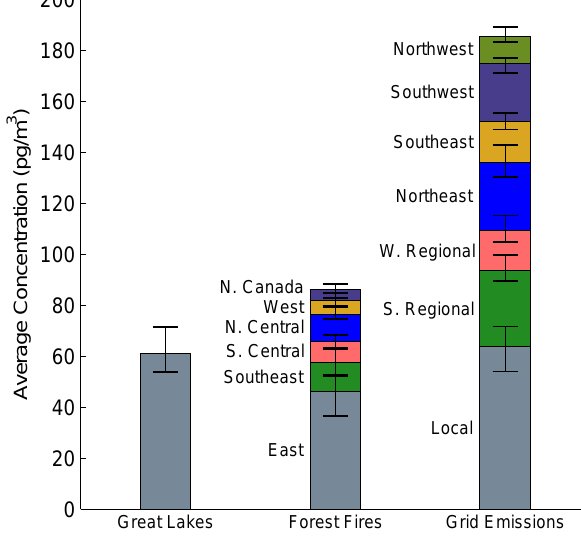
Fig. 12. Impacts from different source groups on the average GEM Fig.12. ImpactsfromdifferentsourcegroupsontheaverageGEMconcentrationatthemeasurementsite. Error concentration at the measurement site. Error bars indicate the inter- barsindicatetheinter-quartilerangeoftheinversemodelestimatesfromthebootstrappedsimulations. Seealso quartile range of the inverse model estimates from the bootstrapped simulations. See also Table